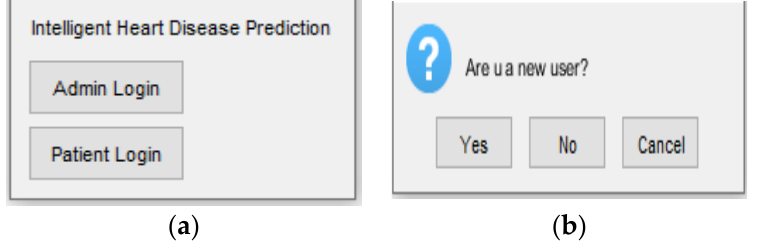
Figure 6. Execution result: ( a ) Intelligent heart disease prediction ( b ) Creating and managing users.